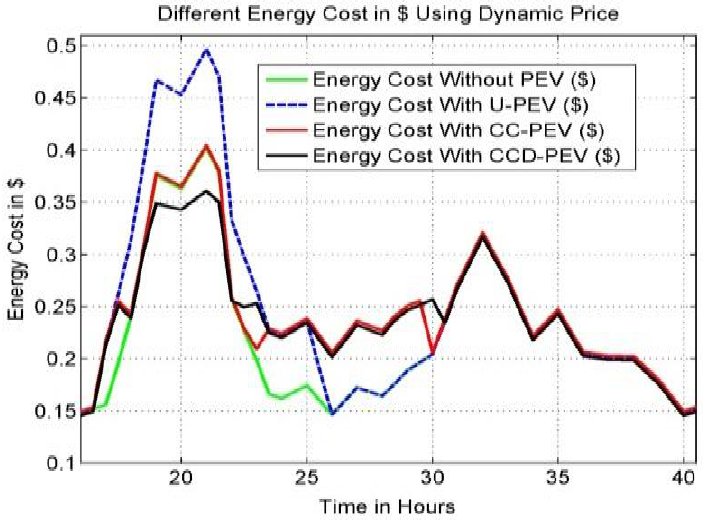
Figure 7. Total cost profiles at home. Table 1. Power quality and losses at home (dynamic